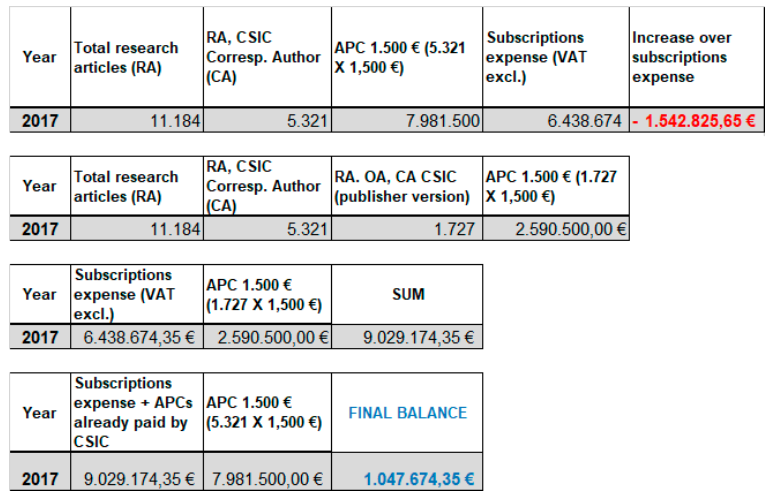
Figure 13. Global Transformative Agreement in CSIC in 2017: A Hypothesis.